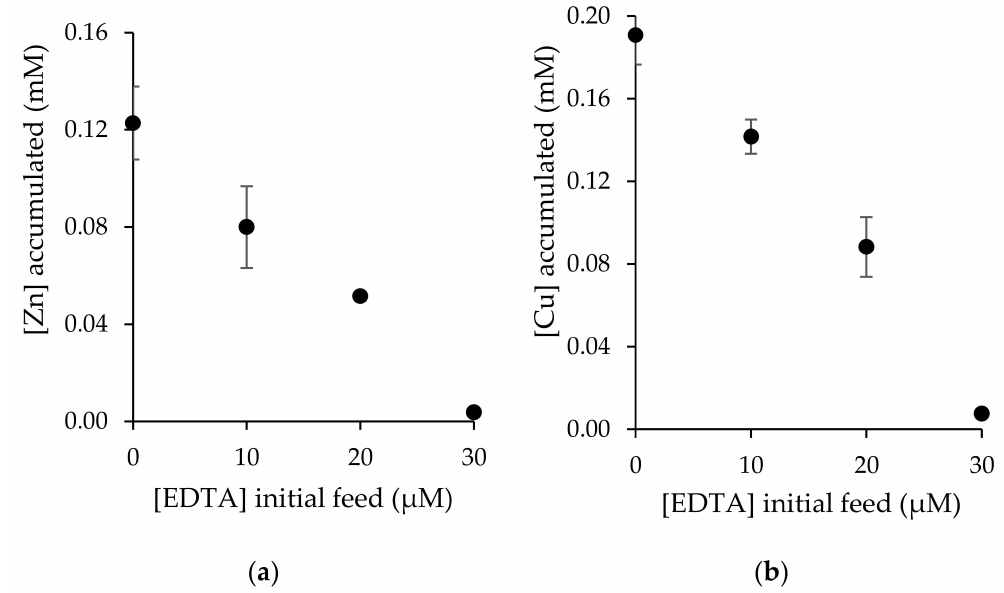
Figure 5. Effect of EDTA on metal accumulation. Feed phase: 100 mL of 0.03 mM of Zn ( a ) or Cu ( b ) in 0.01 M KNO 3 , pH 6.0 and EDTA: 0 to 30 µ M; PIM: M2; receiving phase: 5 mL 0.01 M HNO 3 ( n =